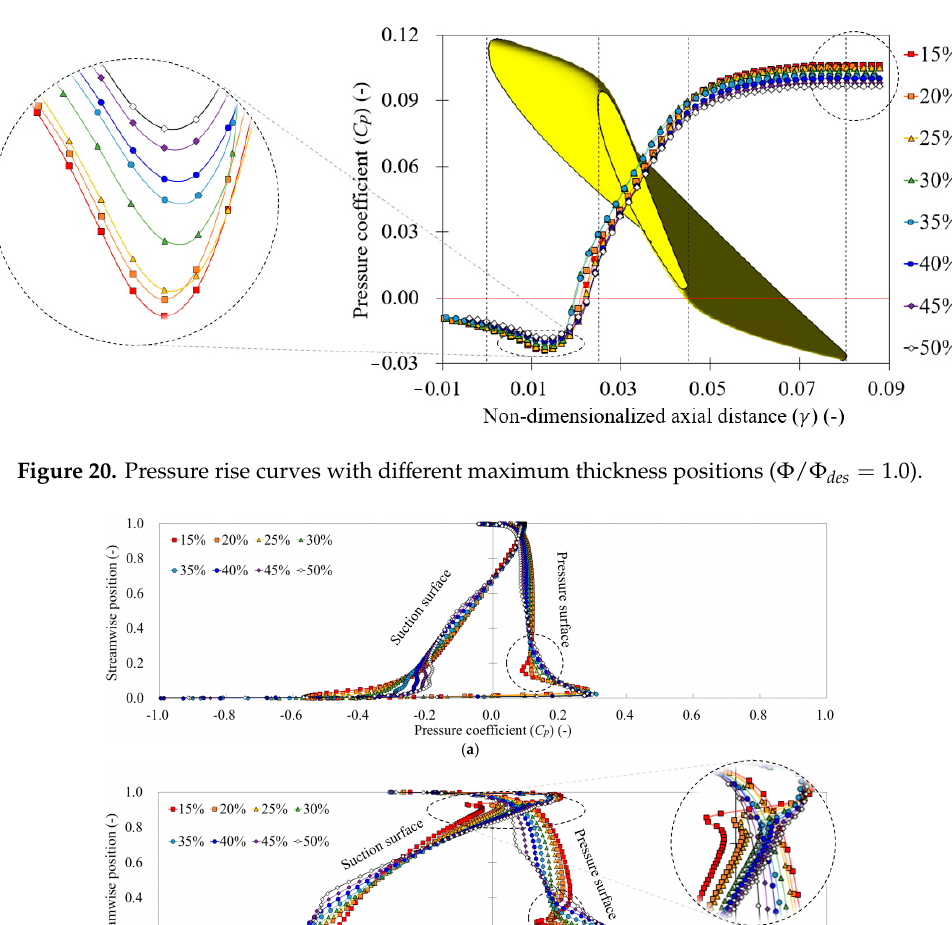
Figure 21. Blade loading curves with different maximum thickness positions ( 𝛷/𝛷 (cid:3031)(cid:3032)(cid:3046) = 1.0 ): ( a ) hub span; ( b ) shroud span.